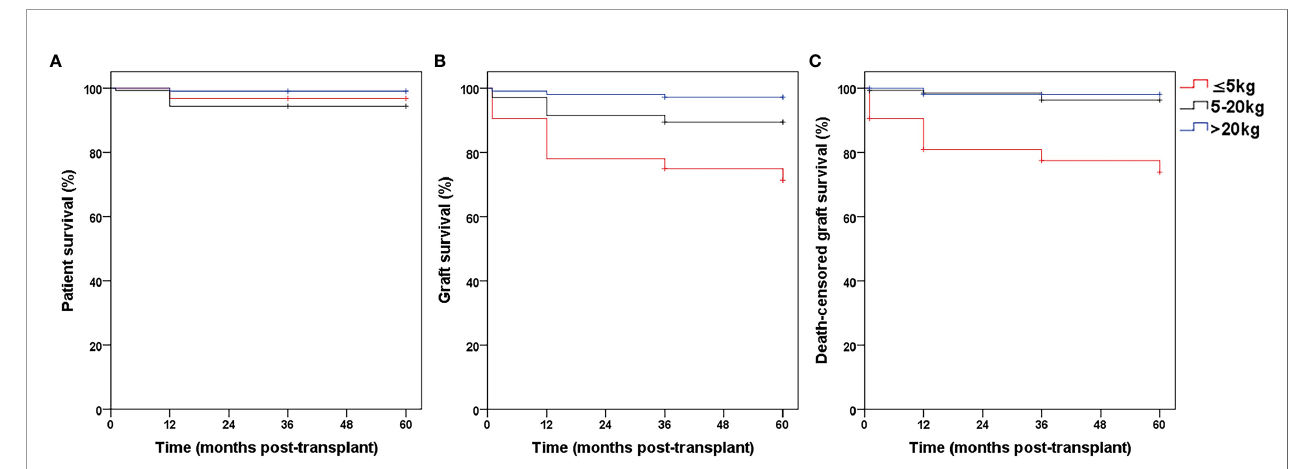
FIGURE 3 | The patient survival ( A , P > 0.05), graft survival ( B , P < 0.05) and death-censored graft survival ( C , P < 0.05) rates in Group 1, 2 and